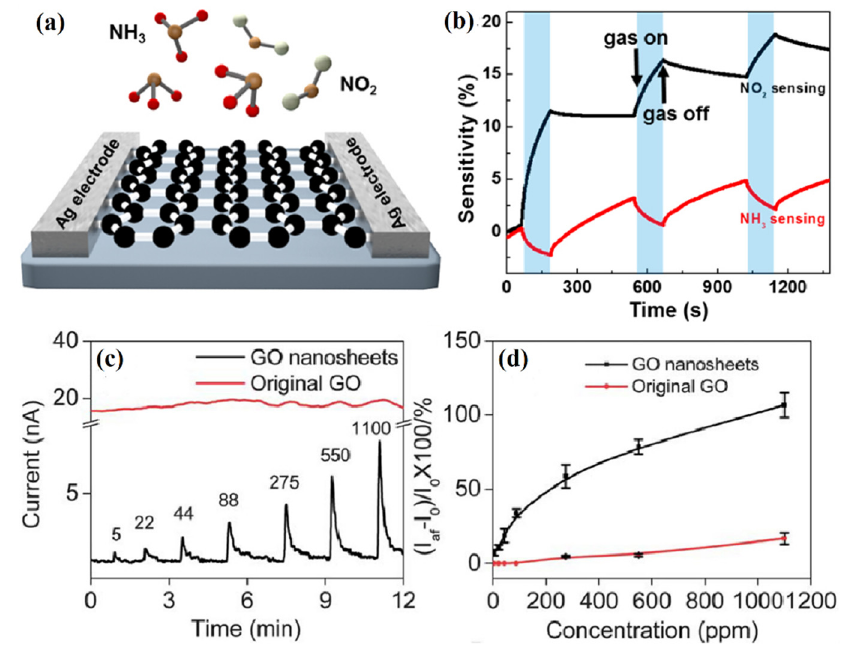
Figure 5. Schematic ( a ) and time-resolved sensitivity ( b ) of the graphene sensor toward NH 3 and NO 2 gas molecules. ( c ) Current vs. time curves for 5–1100 ppm of SO 2 for the original GO and edge- tailored GO nanosheets, and ( d ) the corresponding sensitivities of the sensors to SO 2 gas. Reprinted with permission from Ref. [69]. Copyright 2016 ACS.